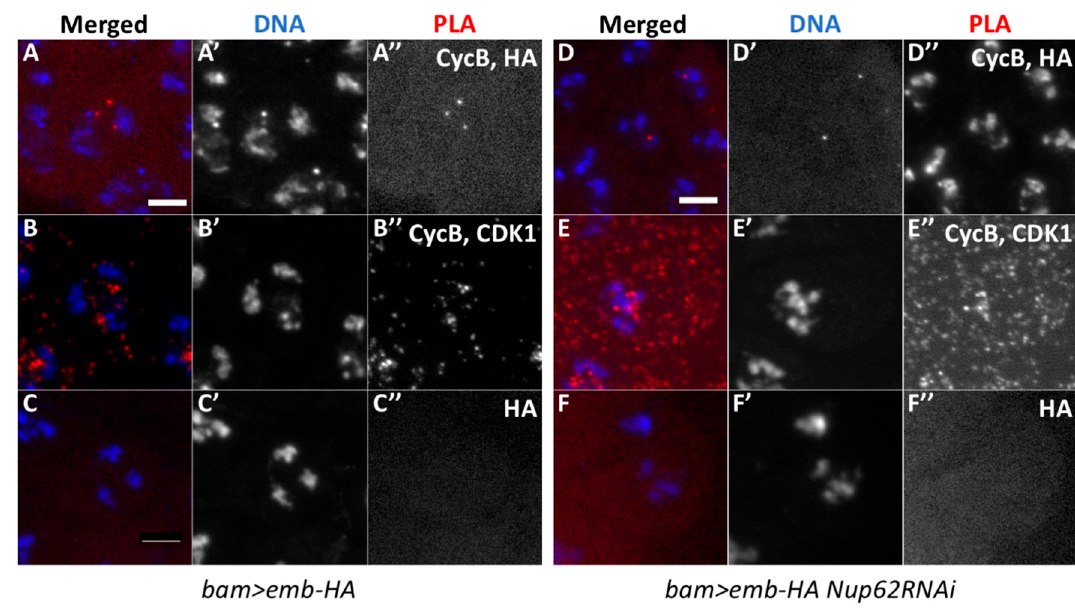
Figure 7. Proximity ligation assay (in situ PLA) showing close association between Emb and CycB in normal premeiotic spermatocytes and Nup62 -depleted cells before initiation of meiosis I. ( A – F ) In situ PLA of premeiotic spermatocytes for detecting protein complexes. The PLA foci are in red ( A – F ) and white ( A” – F” ). ( A ) The PLA foci with anti-CycB and anti-HA antibodies indicate the presence of protein complexes containing CycB and Emb-HA in normal spermatocytes expressing Emb-HA. ( B ) A positive control of the assay with anti-CycB and anti-CDK1 antibodies. ( C ) A negative control for in situ PLA with anti-HA antibody alone (0.31%, n = 318). ( D – F ) In situ PLA of the spermatocytes with Emb-HA expression and depletion of Nup62. ( D ) Assay with anti-CycB and anti-HA antibodies; 20.3% of the Nup62 -depleted cells contained the PLA foci, indicating presence of protein complexes containing CycB and Emb (n = 320). ( E ) A positive control experiment with anti-CycB and anti-CDK1 antibodies (99.4%, n = 167). ( F ) A negative control experiment with only anti-CycB antibody (1.1%, n = 184). Blue; DAPI staining.